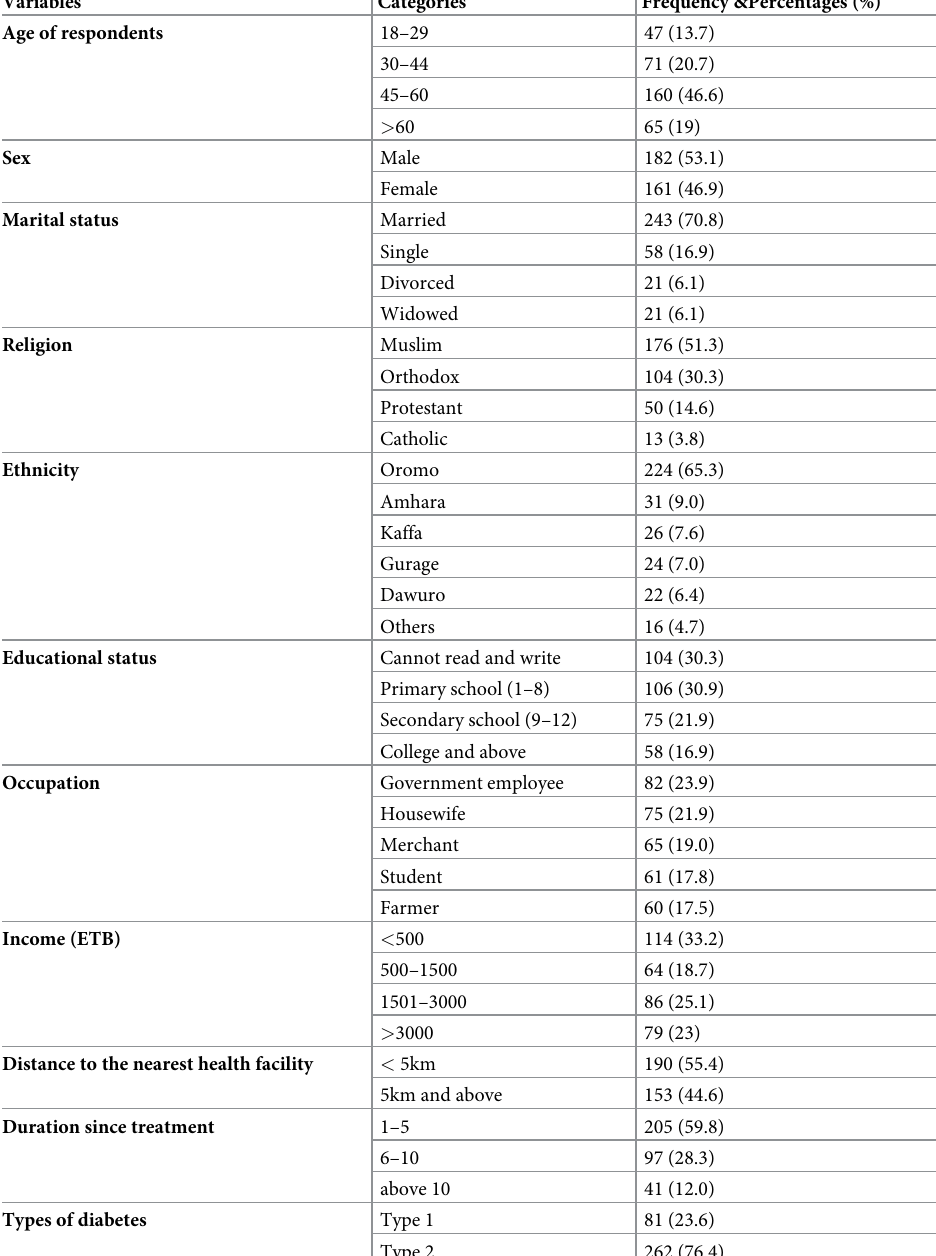
Table 1. Socio-demographic characteristic of patients with diabetes in Jimma University medical center, Ethiopia April 12-May 25 2020 (n =